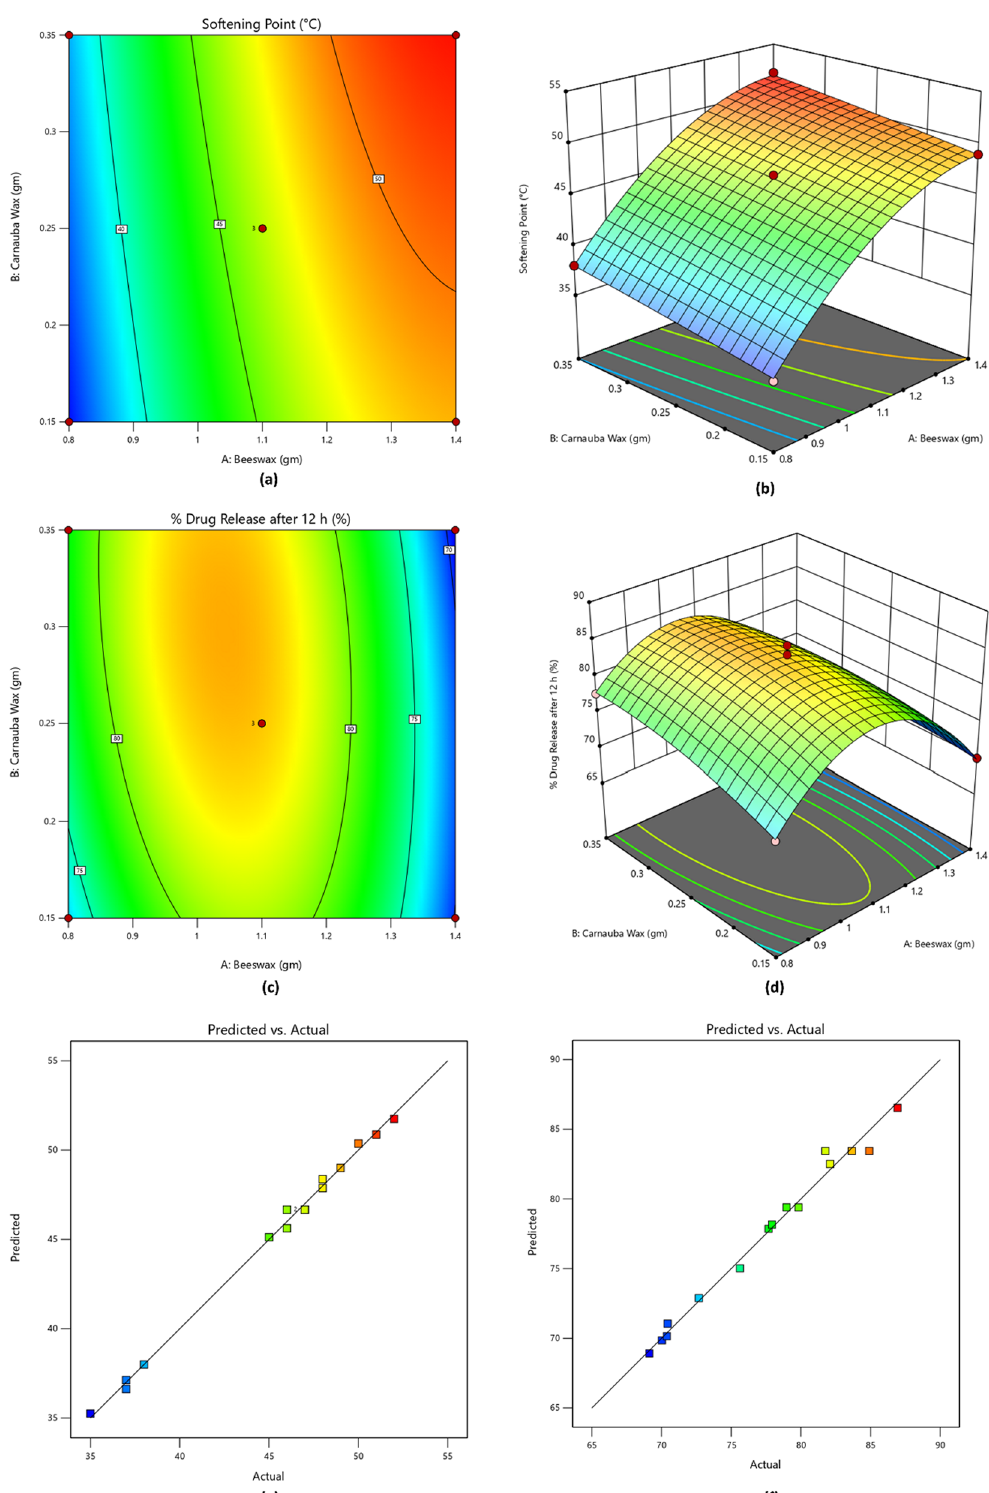
Fig. 4 Illustration of influence of the amount of beeswax and carnauba wax interaction: a Contour plot, b 3D surface plot for softening point and c Contour plot, and d 3D surface plot for percent drug release after 12 h. A comparison of the predicted and actual experimental data of the lipstick formulation is given in ( e ) softening point, and ( f ) percent drug release after 12